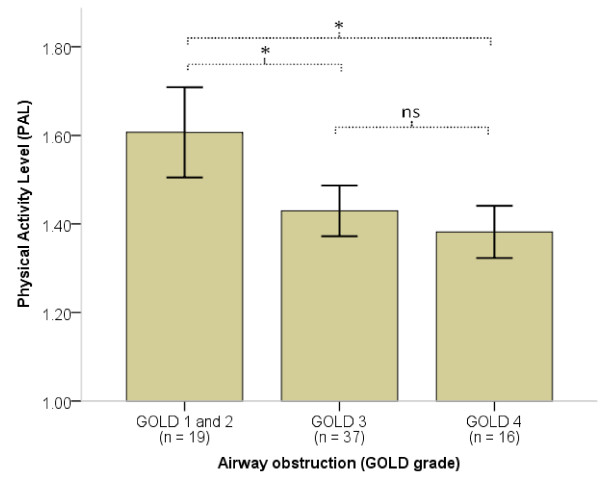
Physical activity level (PAL) presented across the airway obstruction classification from the Global Initiative for Chronic Obstructive Lung Disease (GOLD). Bars are the mean PALs (with 95% CI) in respective GOLD grades. * = p < 0.05, ns = p > 0.05.